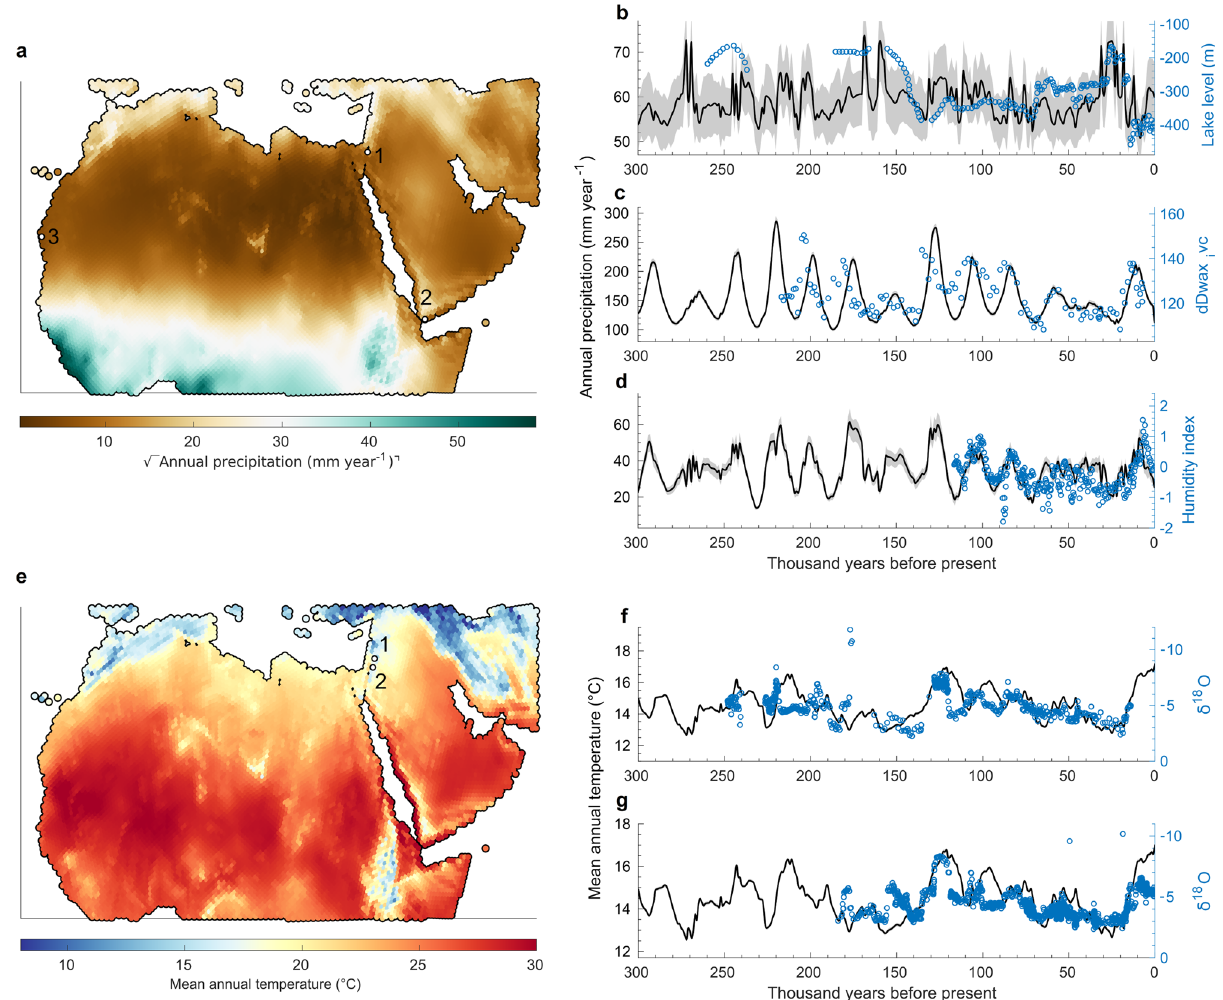
Fig. 4 Comparison of our data to long-term proxy records. a Geographical locations of empirical proxies on a map of present-day annual precipitation. b – d Comparisons of simulated annual precipitation against the three wetness proxies. e Geographical locations of empirical proxies on a map of present-day mean annual temperature. f , g Comparisons of simulated mean annual temperature against the two δ 18 O records. Black lines represent the simulated climatological normals at 1k-year intervals (Eqs. (2) and (6)), grey shades represent the 10th and 90th percentile of the decadal simulations ( n = 100; Eqs. (4) and